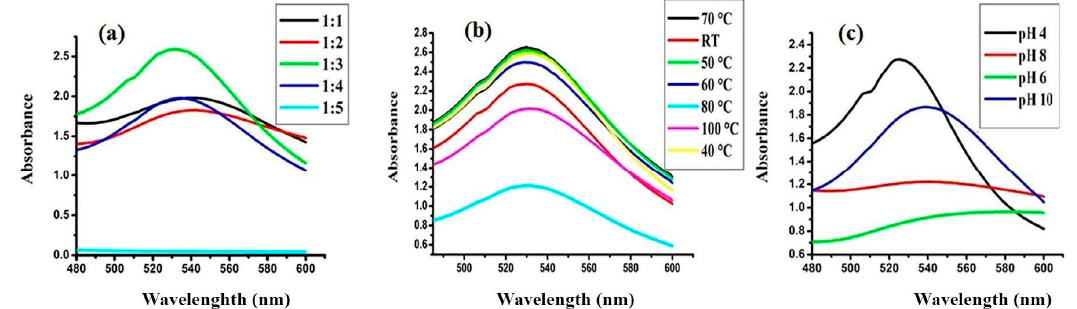
Figure 2. UV-Vis spectra of flavonoid coated gold nanoparticles (FAuNPs) synthesis at di ff erent ( a ) flavonoid / HAuCl 4 ratios, ( b ) temperature, and ( c ) pH.